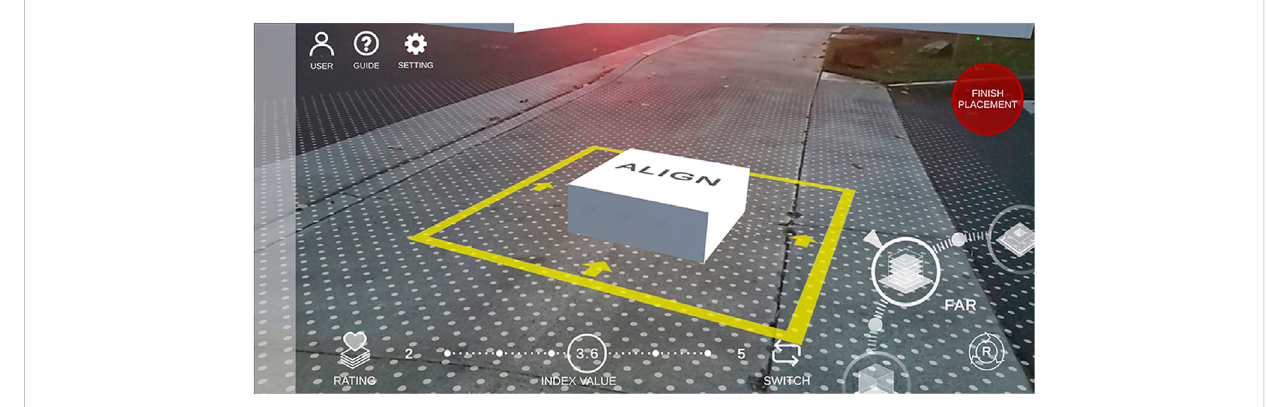
FIGURE 4 Virtual model placement on the site. Created with Unity Personal version and AR Foundation package.